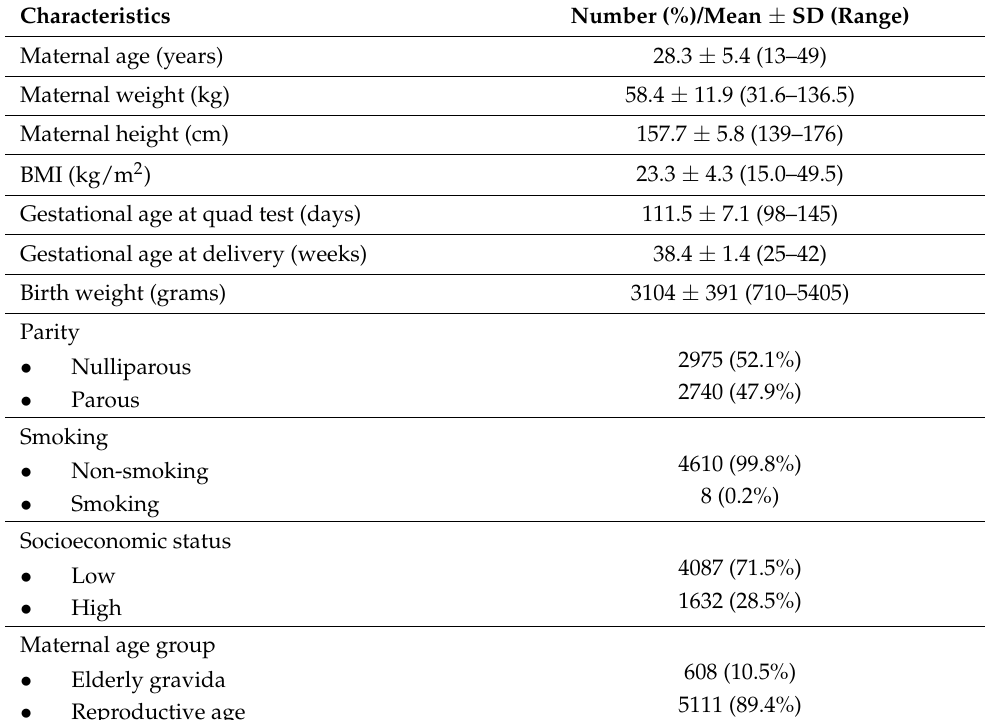
Table 1. Baseline characteristics of the